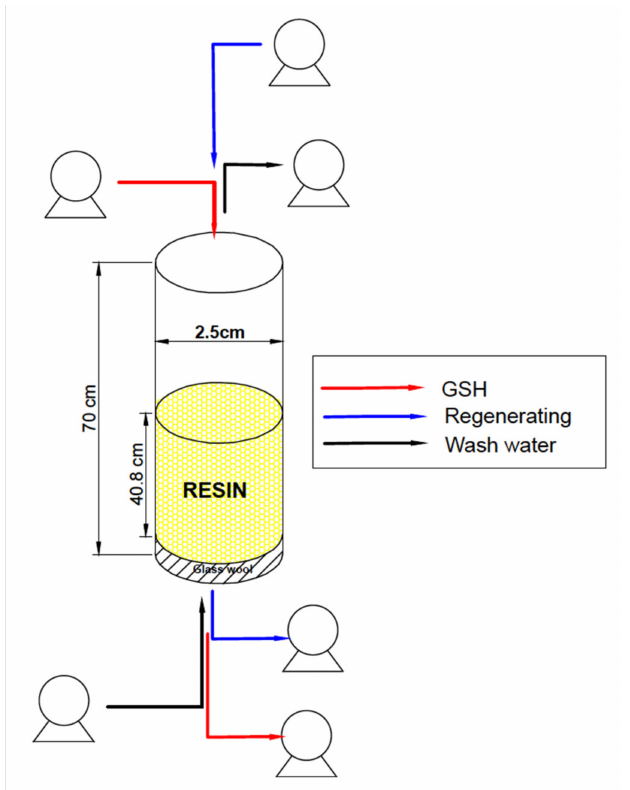
Figure 2. Column designed with a length of 70 cm and an internal diameter of 2.5 cm packed with 140 g of iminodiacetic resin equivalent to a volume of 200 cc. A 71.5% of expansion rate was